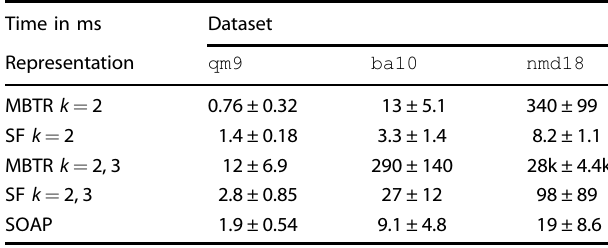
Table 5. Computational cost of calculating